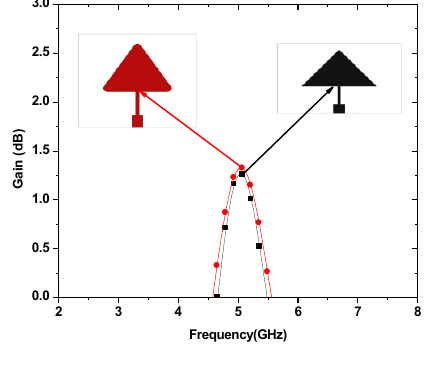
Figure 5: Comparative analysis of S11 of CTPA for quarter wave width variation